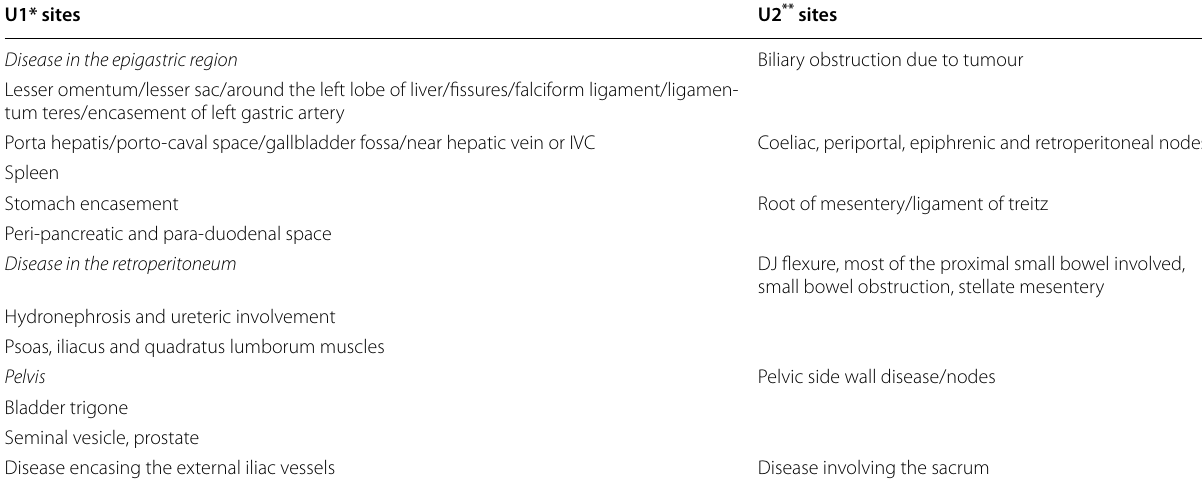
Table 1 Review areas for unfavourable sites [44] (published with permission from clinical radiology)